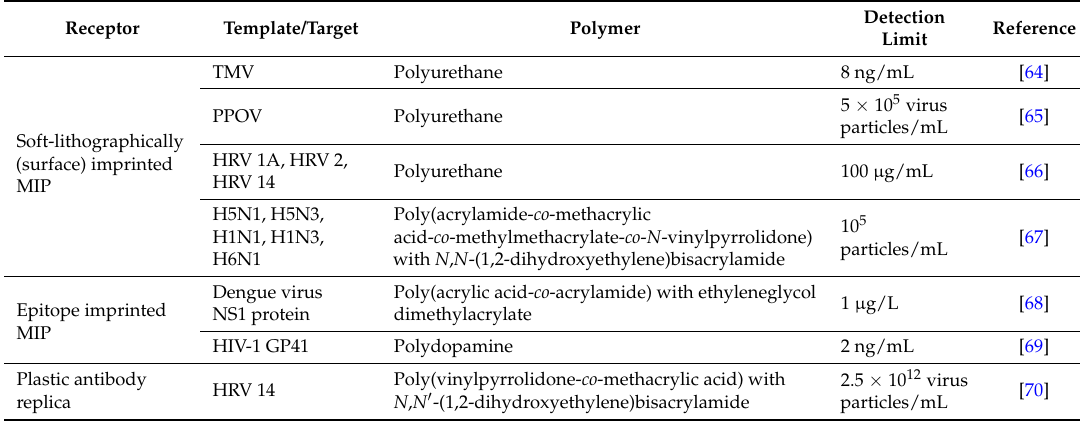
Table 1. The selected examples of the molecularly imprinted polymers (MIP) as synthetic receptors for QCM-based viral